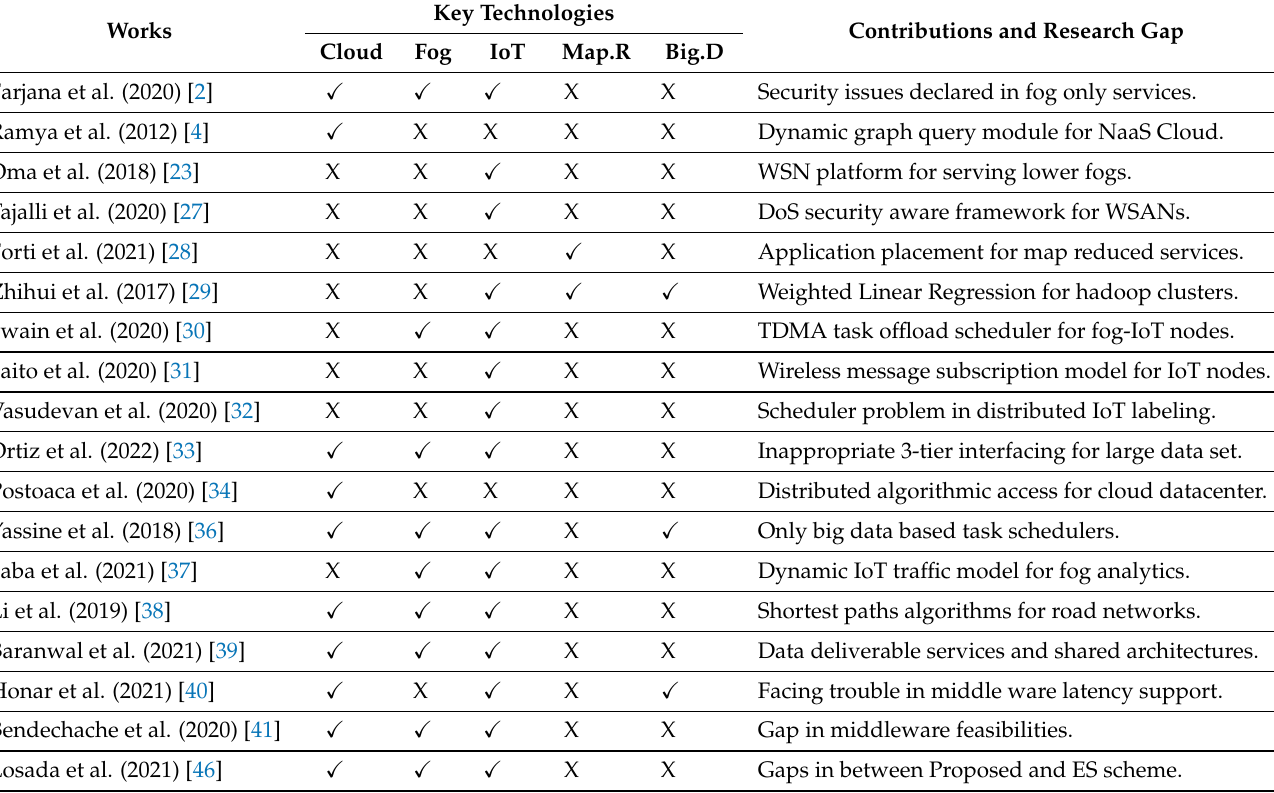
Map.R—declares map reduce, Big.D—declares big data in Table